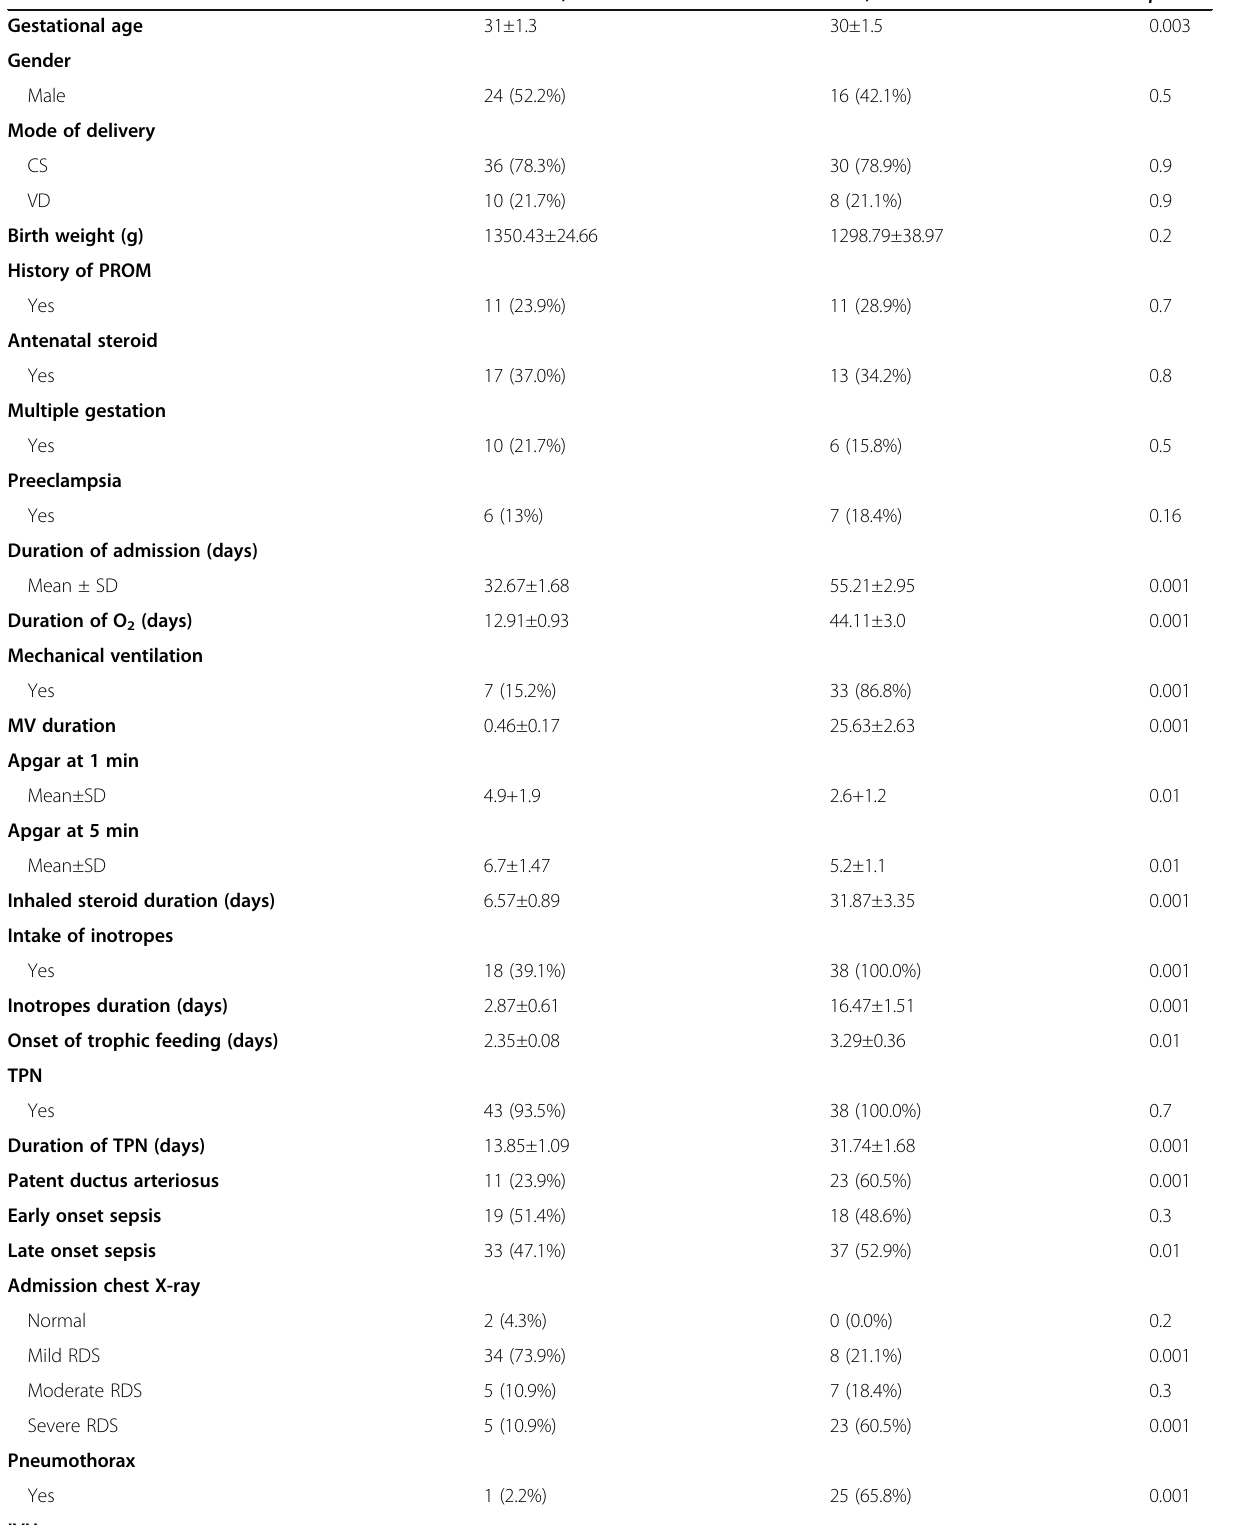
Table 1 Demographic and clinical